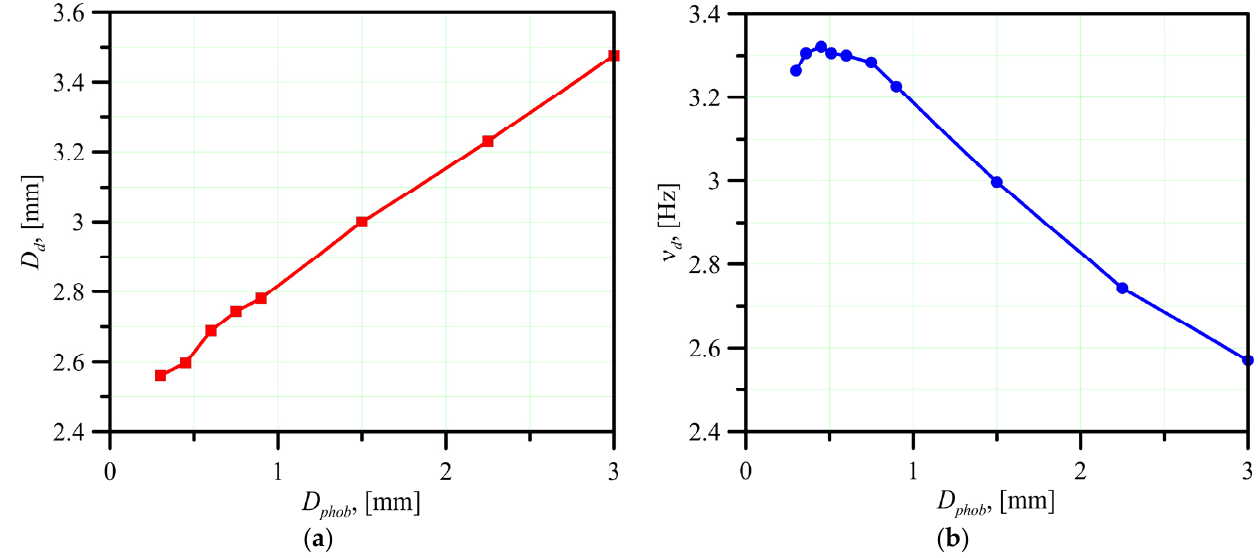
Figure 6. ( a ) Bubble departure diameter D d and ( b ) departure frequency ν d depending on the lyophobic zone width D phob . Heater temperature T h = 0.95 T c